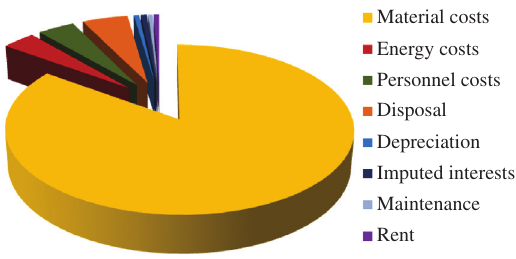
Figure 7 Composition of production costs for the epoxidized soybean oil (ESBO) fed-batch production plant.